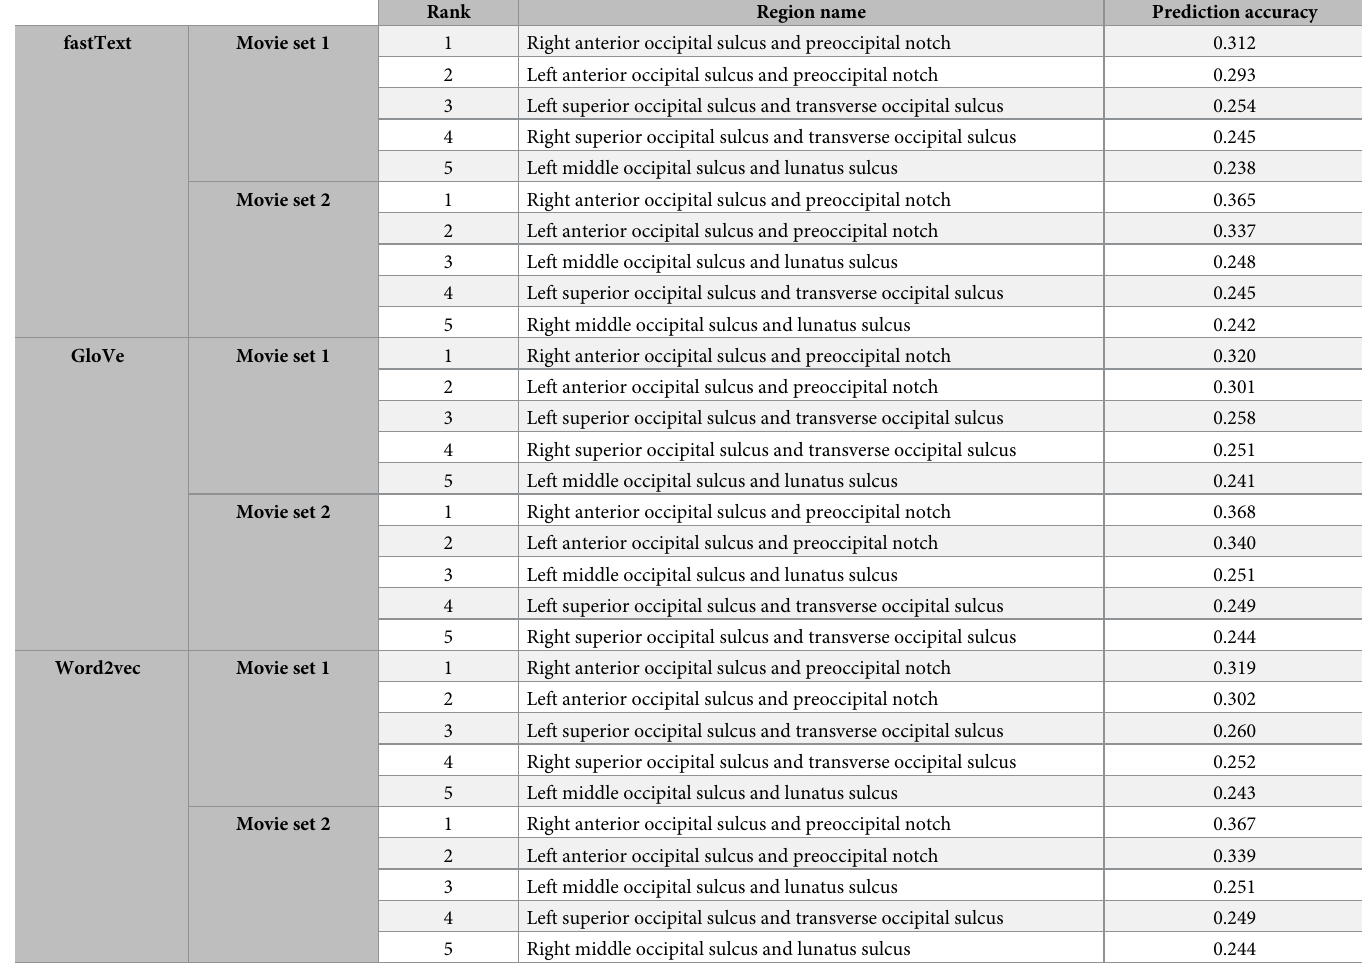
Table 1. Cortical regions with the highest mean prediction accuracy for each type of word vectors and for each movie set.